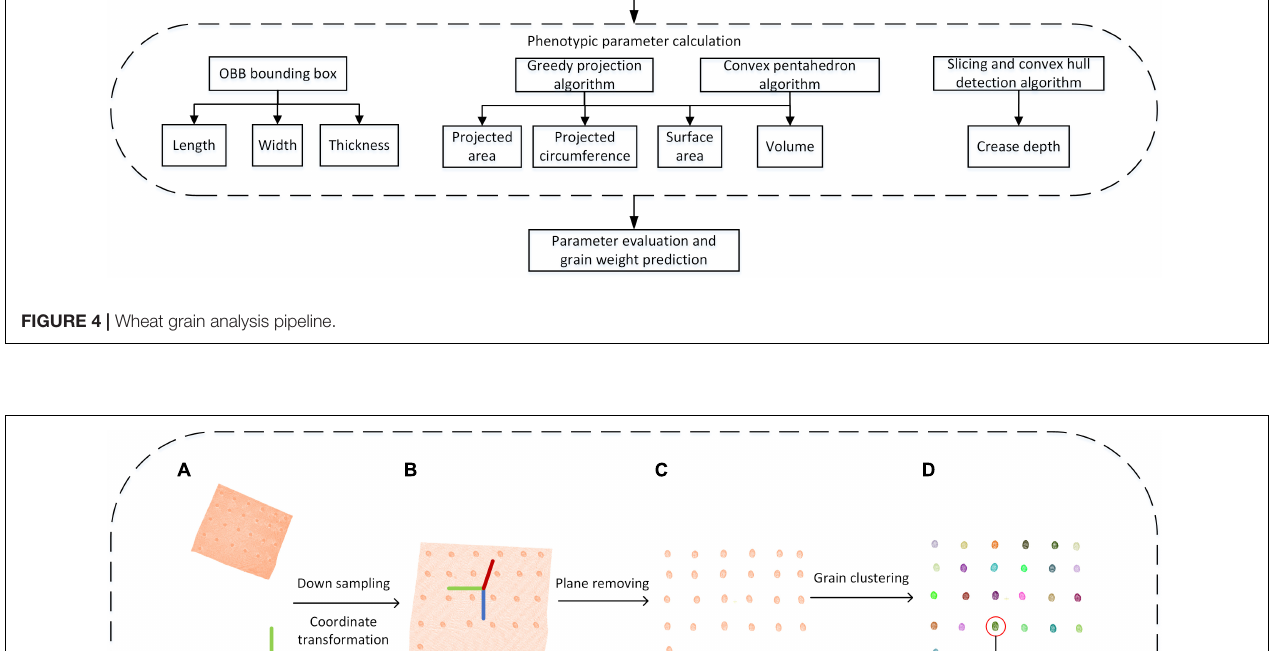
Frontiers in Plant Science |